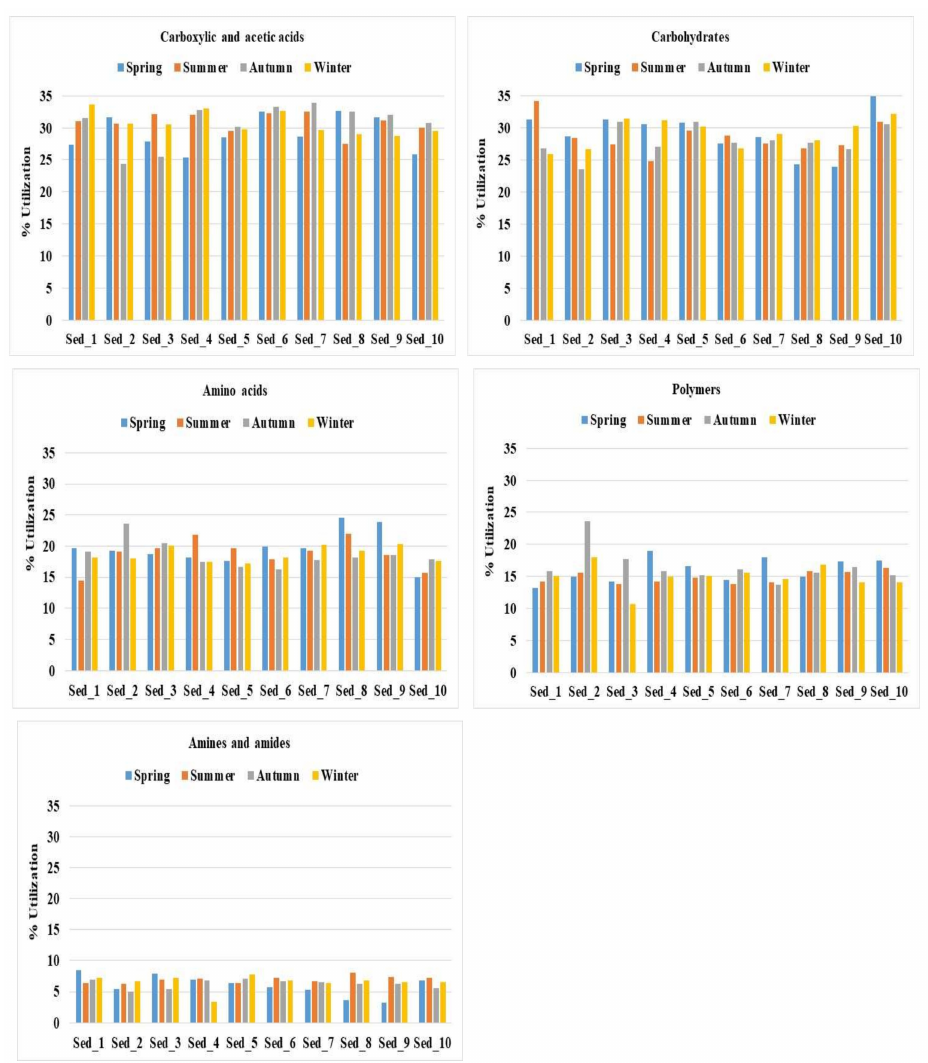
Figure 7. Total carbon source utilization response (%) in 10 bottom sediments sampled during spring, summer, autumn, and winter for the different carbon substrate